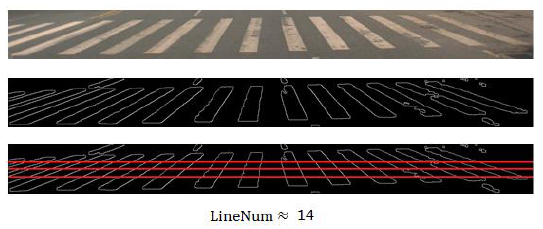
Figure 6. AOI map, contour map, crossing line map of a crossing with sub-clarity, as well as strip number calculated